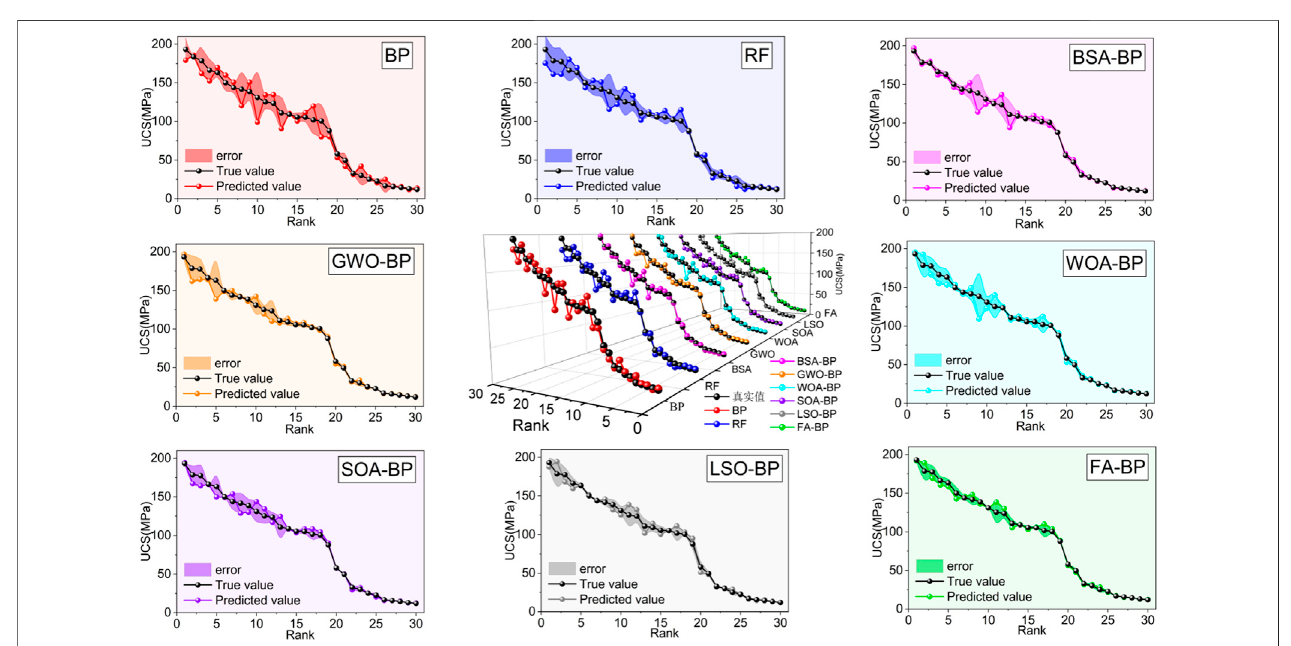
FIGURE 7 | Predicted vs. true